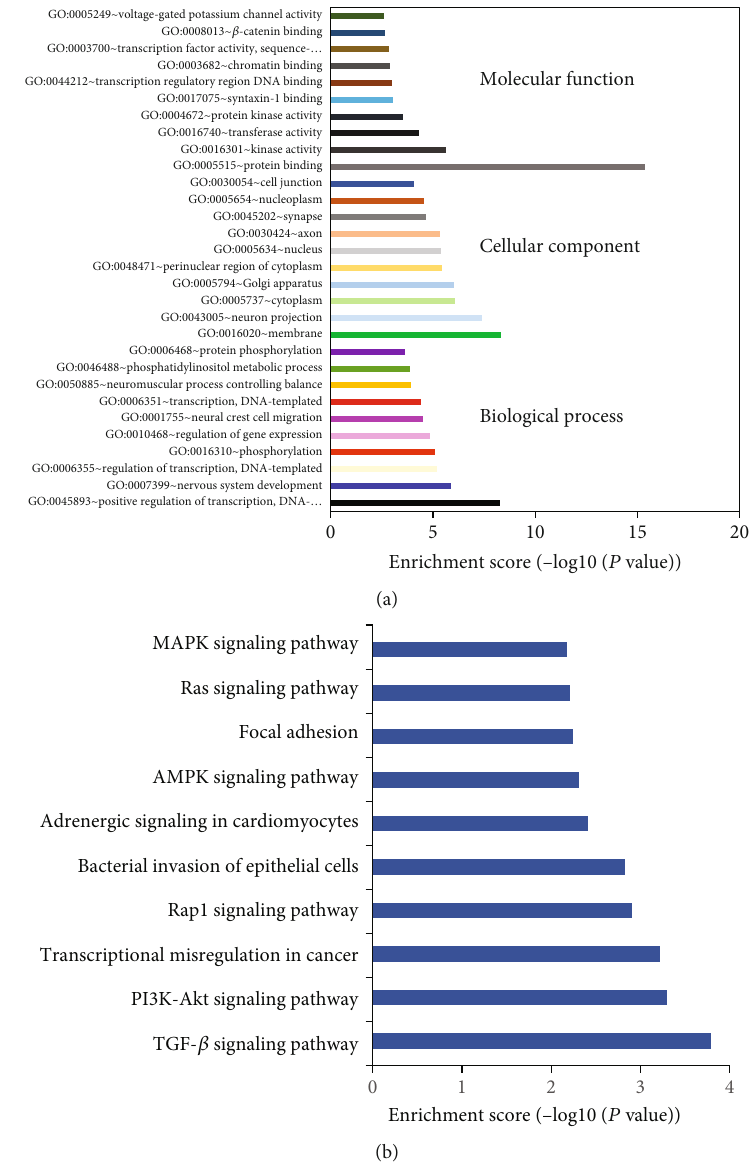
Figure 6: GO terms and KEGG pathway enrichment analysis of circRNA 000286 and 017277-related mRNAs. (a) Top 10 biological process, cellular component, and molecular function of GO terms for the analysis of circRNA 000286 and circRNA 017277-related mRNAs. (b) Top 10 KEGG pathway for analysis of the two